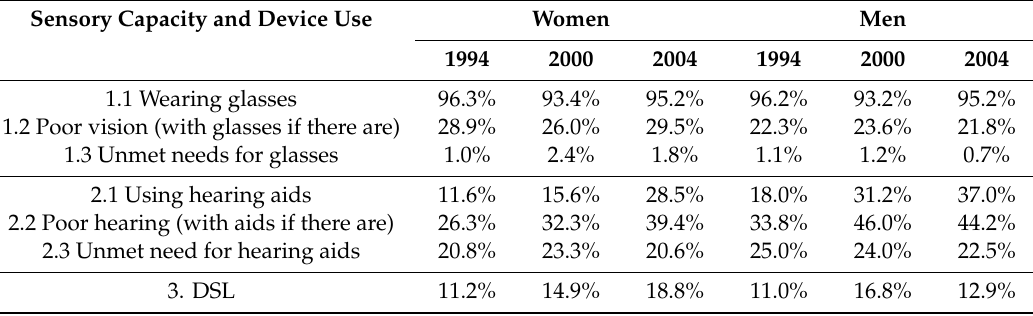
Table 3. Sensory capacity and the use of glasses and hearing aids in 1994, 2000 and 2004. Sensory Capacity and Device Use Women Men